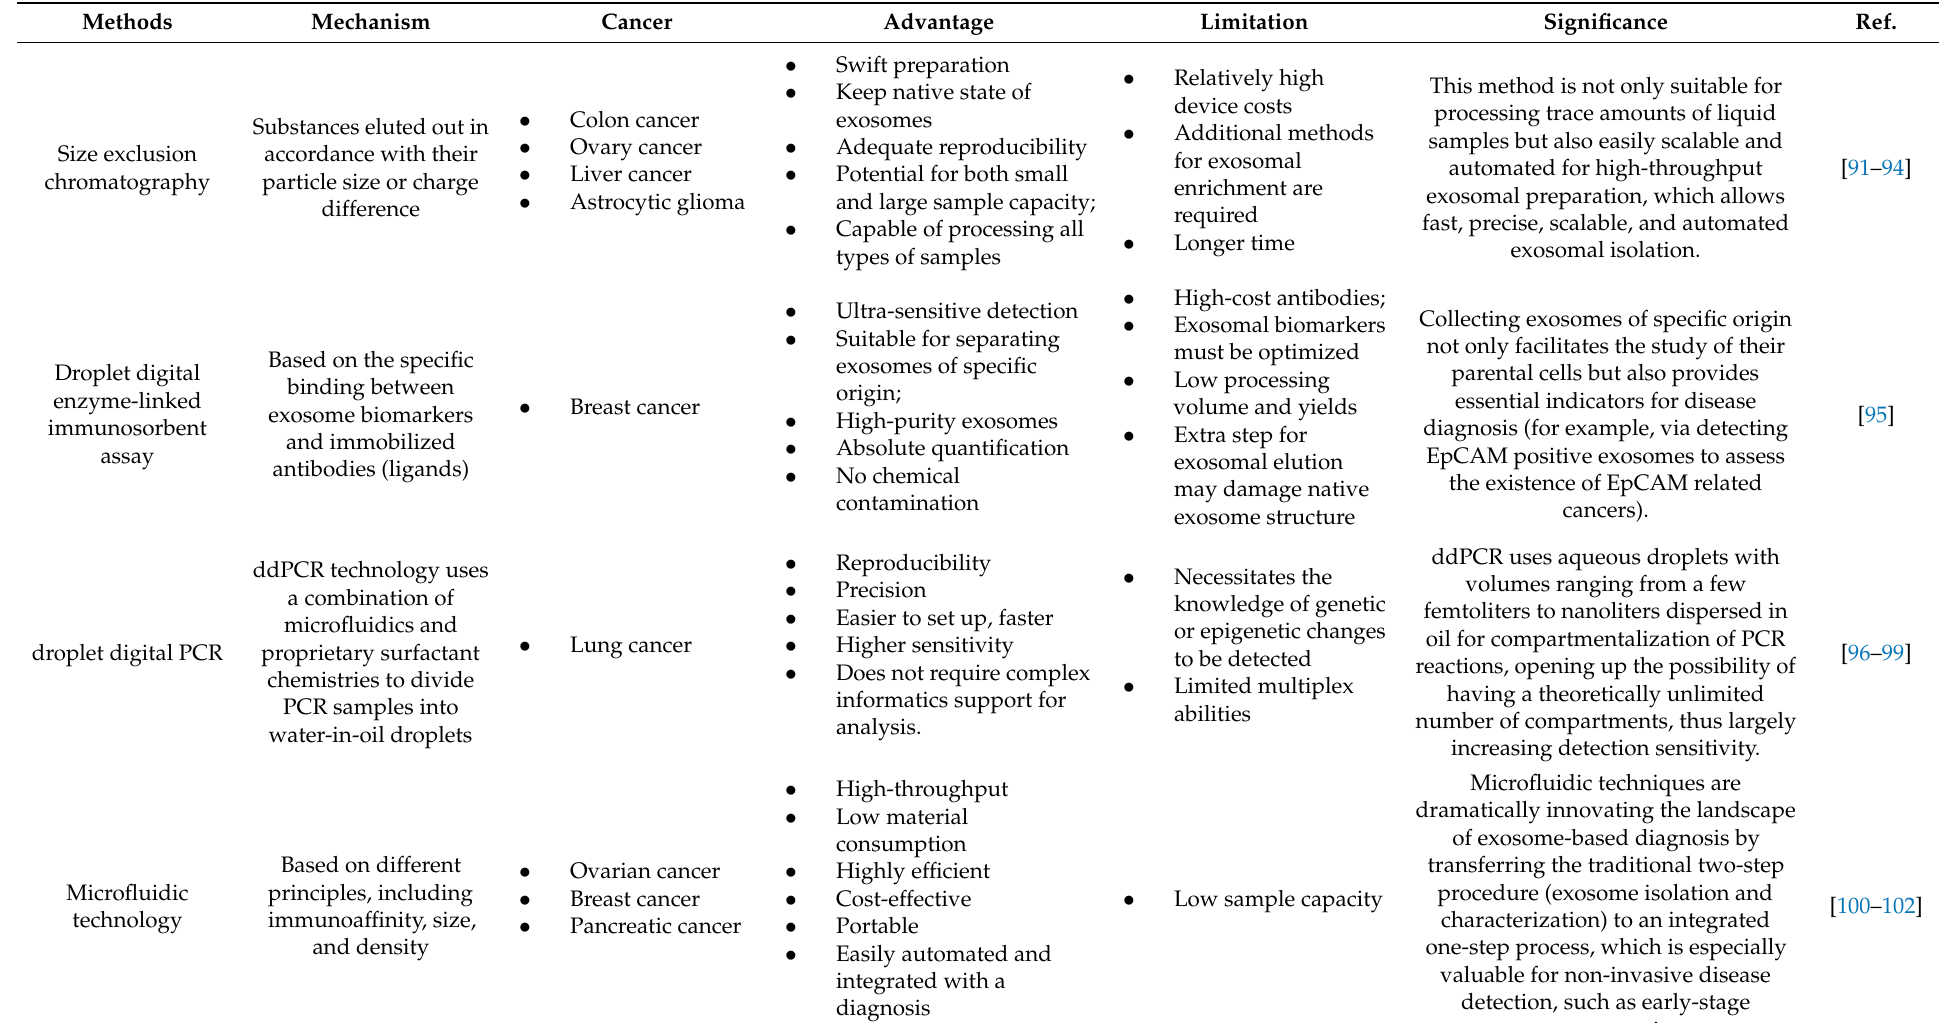
Table 2. Comparison of seven types of detection strategies for exosomes and